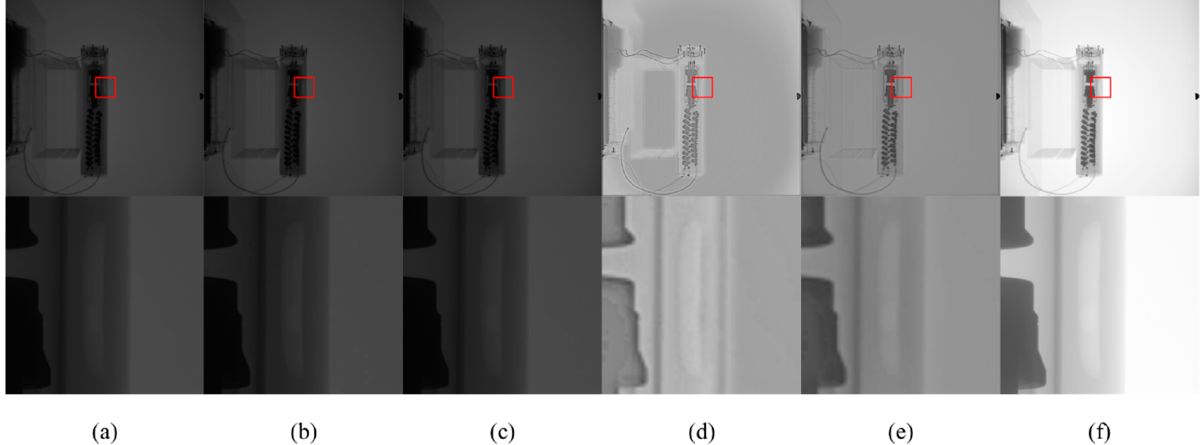
Figure 16. The contrast enhancement results of different methods. Top: raw image and the enhance- ment results; bottom: zoomed-in views on the highlighted area. ( a ) The raw images; ( b ) CLAHE; ( c ) LCM-CLAHE; ( d ) Retinex-Net; ( e ) Zero-DCE; and ( f ) our method.